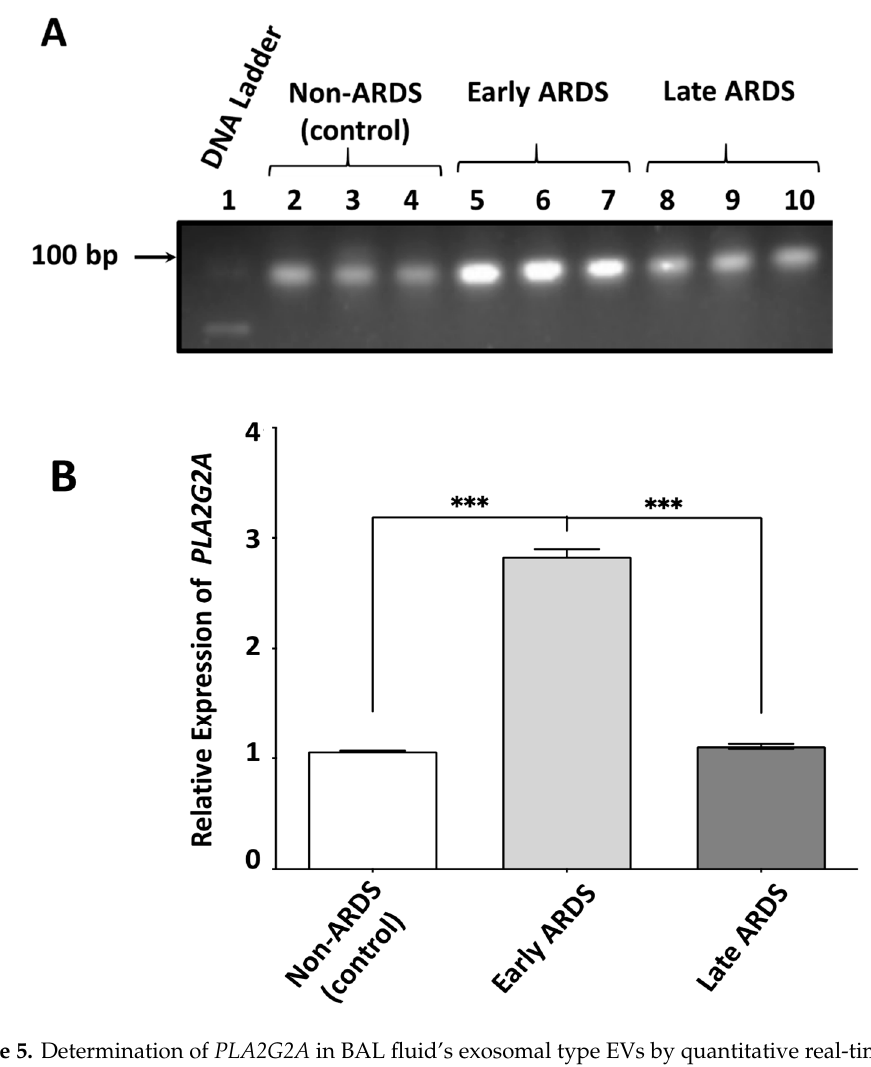
Figure 5. Determination of PLA2G2A in BAL fluid’s exosomal type EVs by quantitative real-time PCR. Exosomal type EVs were isolated and purified from BAL fluids of 9 patients with early phase ARDS, 5 late phase ARDS and 7 non-ARDS-control subjects. ( A ) Electrophoretic analysis of qRT-PCR (cDNA) products using 2% agarose gel. The PLA2G2A -specific band was identified at 86 bp. Pictures show representative mRNA isolations from three different patients per group. ( B ) Relative expression of PLA2G2A in EVs from BAL fluid. The expression levels of PLA2G2A were normalized to those of GAPDH . The data represent the Means ± SE analyzed in duplicates. *** p < 0.001: statistical significance as assessed by one-way ANOVA test.